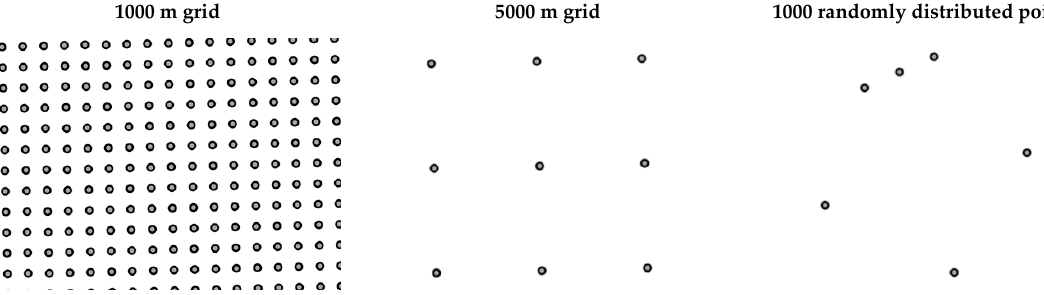
Figure 4. Manner of distribution of control points (analysis of the shape of cells).